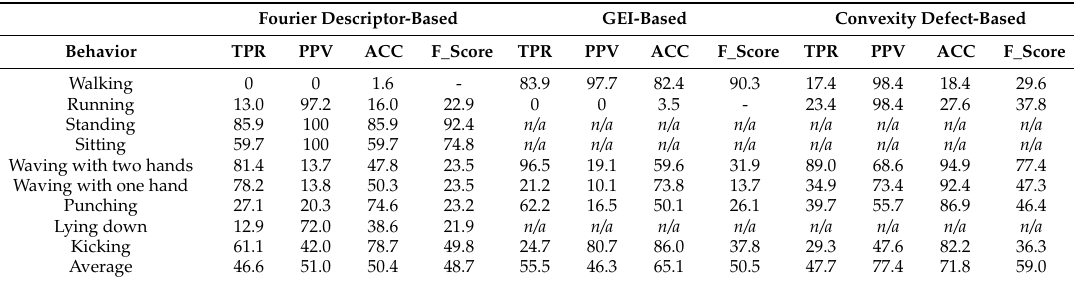
Table 7. Accuracies of other methods (unit: %)